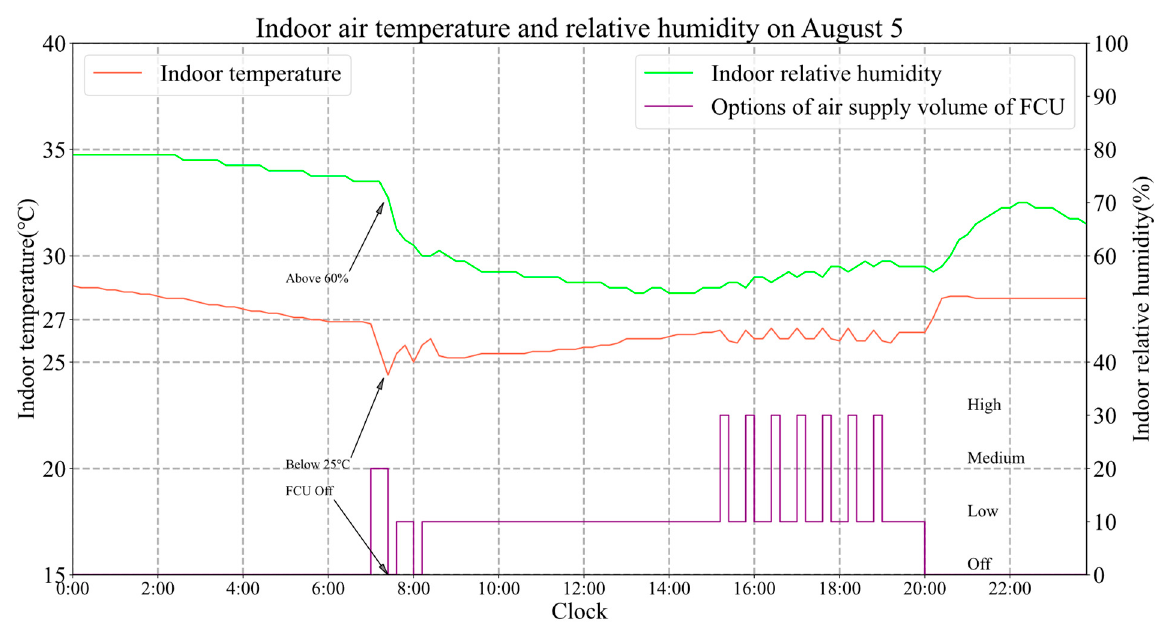
Figure 10. Indoor air temperature and relative humidity on August 5.